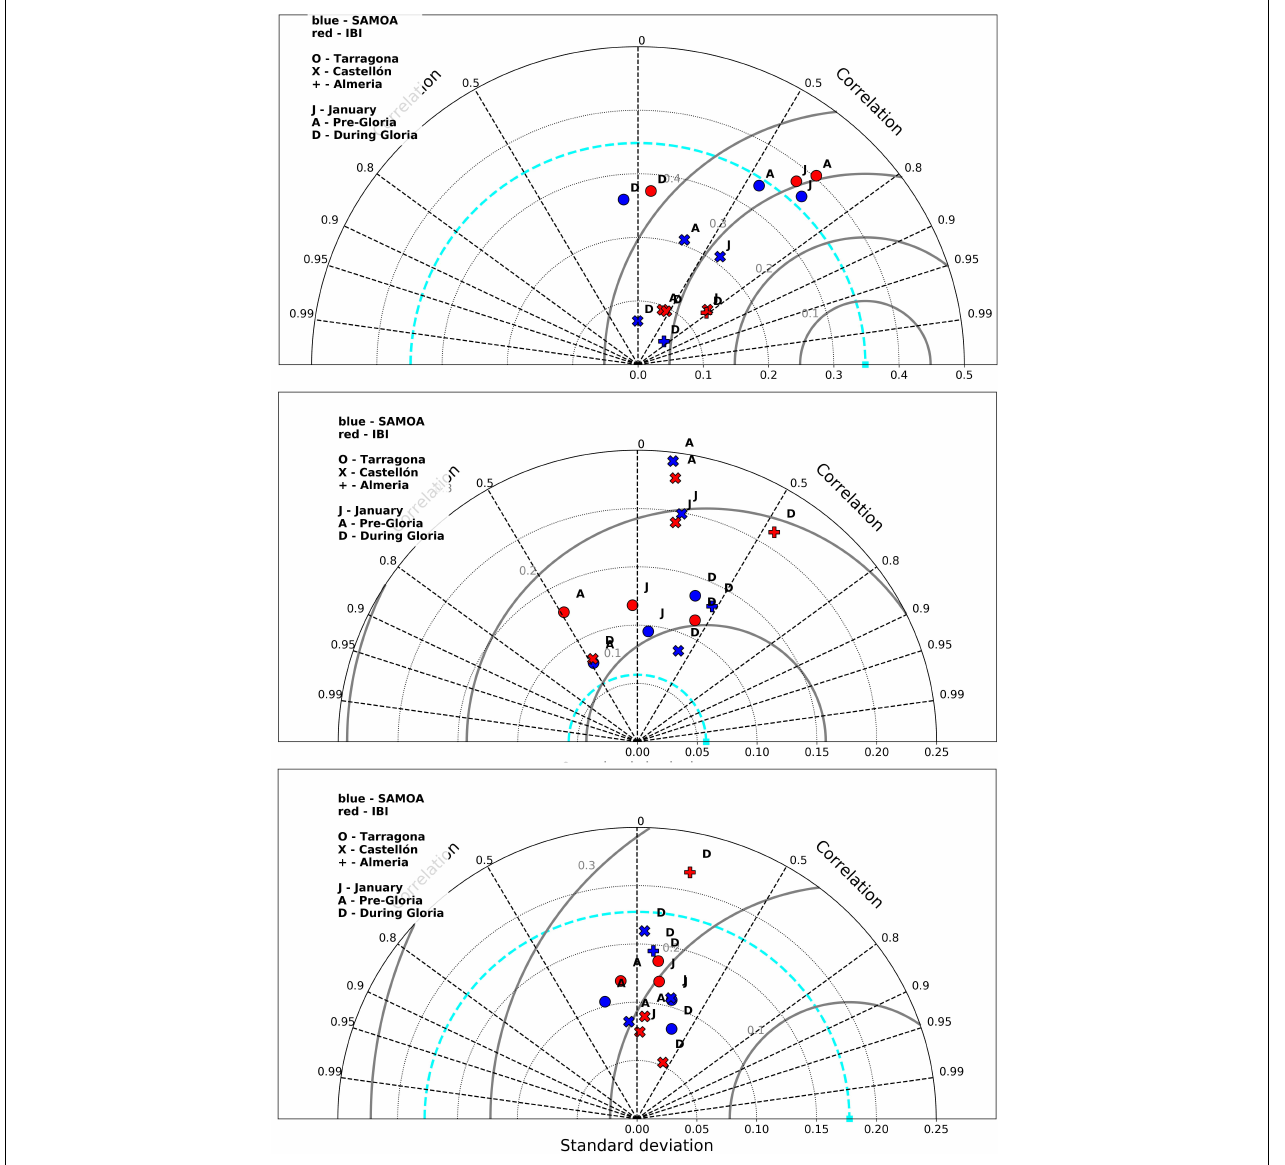
FIGURE 8 | Taylor diagrams comparing IBI and SAMOA forecasts with buoy data in three SAMOA domains (SAM-TAR, SAM-CAS, and SAM-ALM), for January 2020, the pre-Gloria period (January 1st to 18th), and during the storm (January 19th to 25th). Panels from top to bottom for sea surface temperature, surface salinity, and current